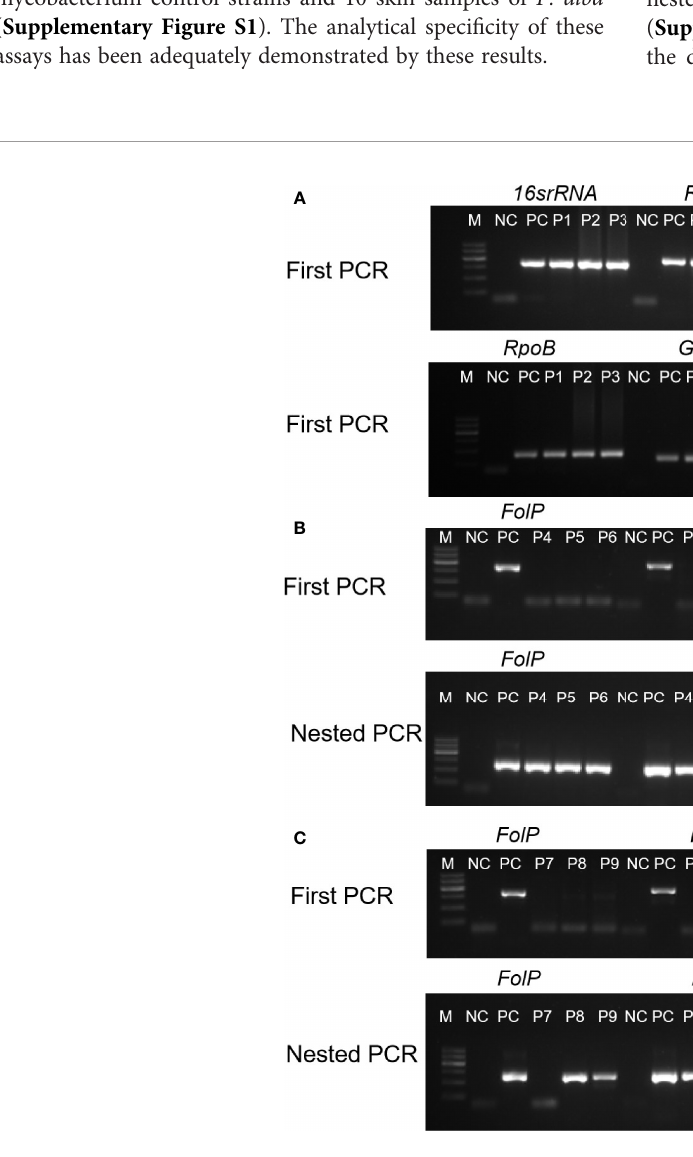
FIGURE 1 | Examples of cases diagnosed via PCR and nested PCR were decisive in the clinically diagnosed new PB leprosy. The horizontal axis indicates the products of fi ve DNA targets by agarose gel. Samples form clinically diagnosed PB leprosy could be detected by fi rst PCR (A) , fi rst PCR with nested PCR (B) , and nested PCR with one of target genes (C) . M, marker; NC, negative control; PC, positive control; P1 – P9, clinical